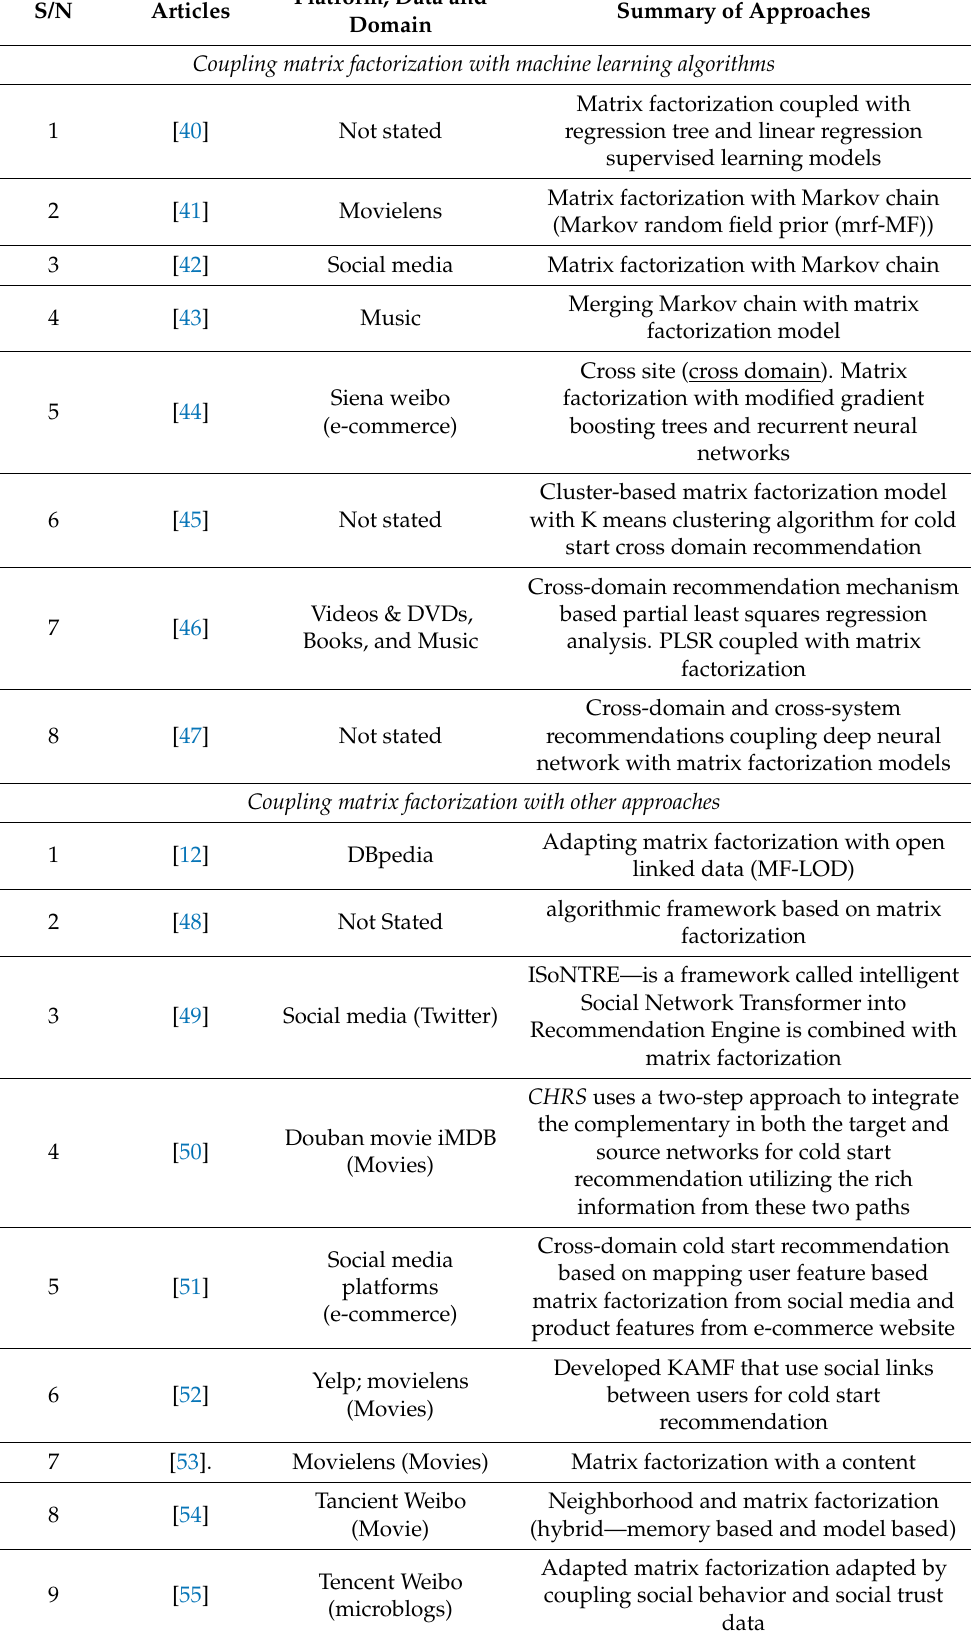
Table 2. Adapting matrix factorization model.